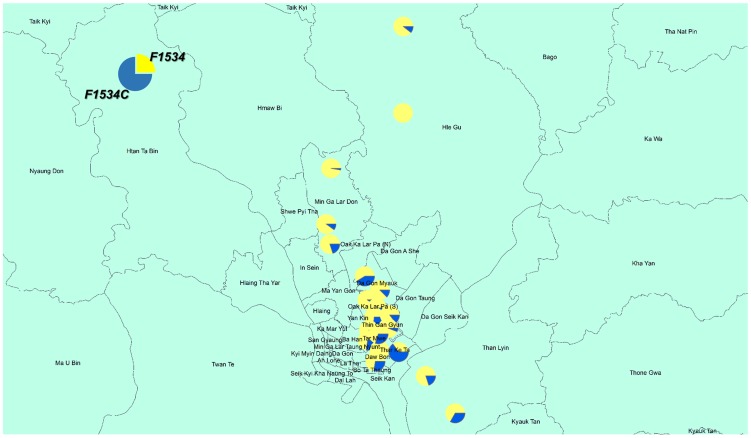
Distribution of the F1534C point mutation in Aedes aegypti larvae.The larvae were collected from used tires in Yangon City. Each circle indicates the allelic composition of the point mutations/wild types.